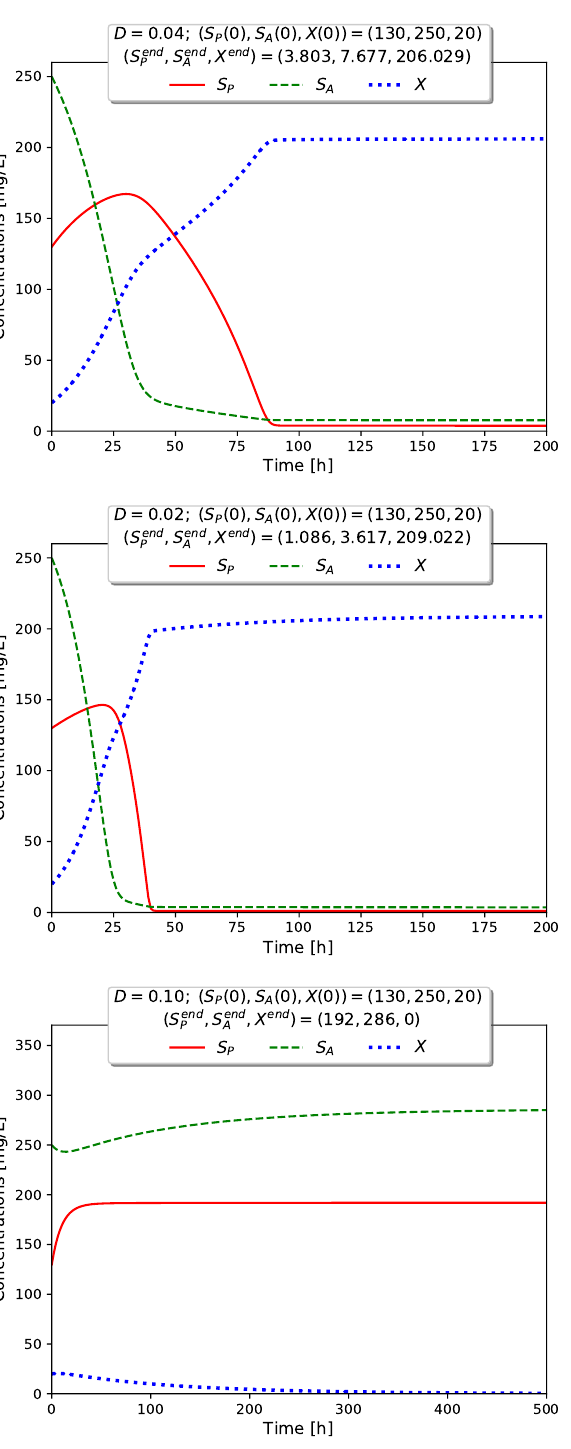
Figure 4 visualizes the time evolution of S P ( t ) , S A ( t ) and X ( t ) for the 3 different values of D corresponding to Examples 1–3.